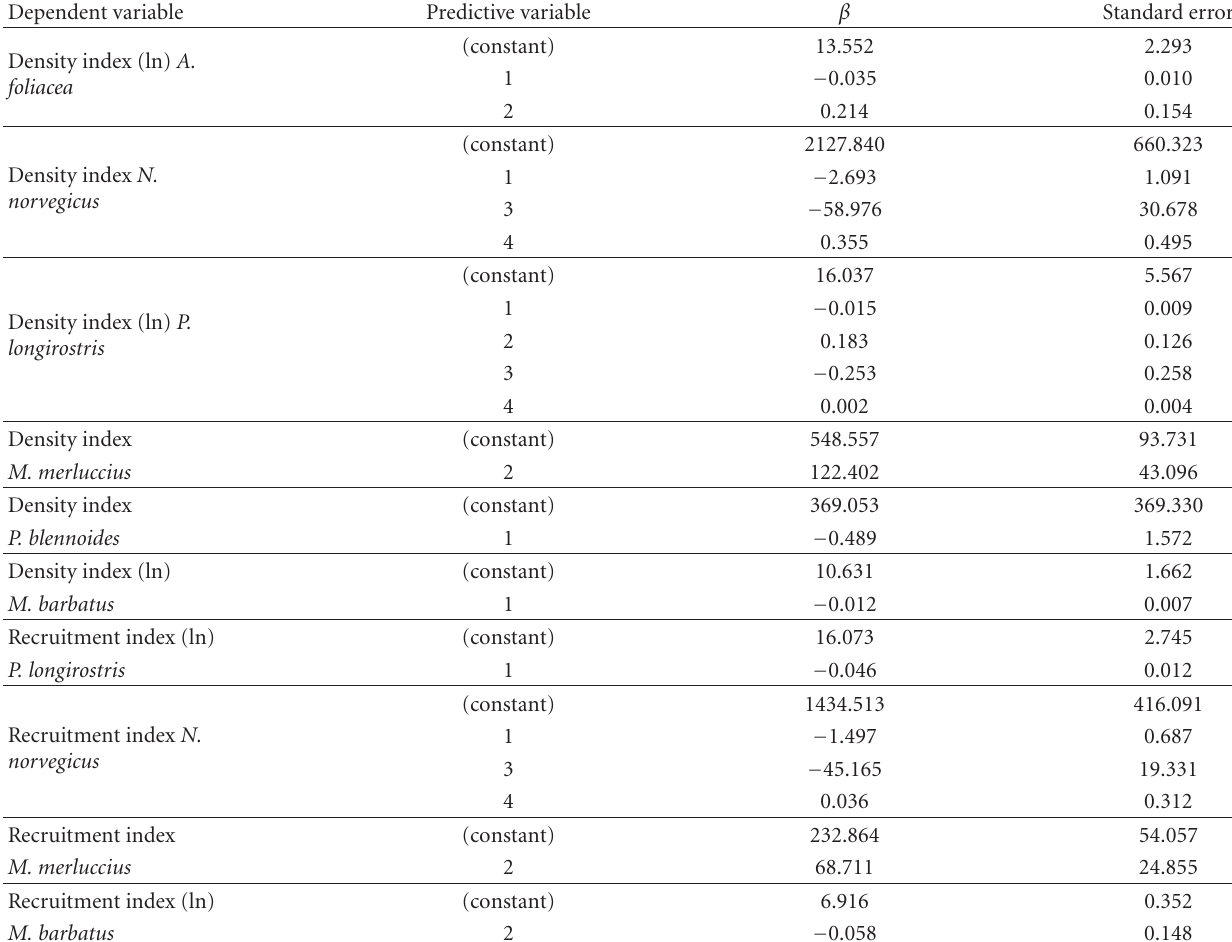
Table 3: Estimated regression coe ffi cients and relative standard errors in the models selected on the basis of AIC c , Δ i for AIC c and Akaike weights ( w i ) values. Predictive variables are: 1: fishing e ff ort, 2: NAO index, 3: SST and 4: